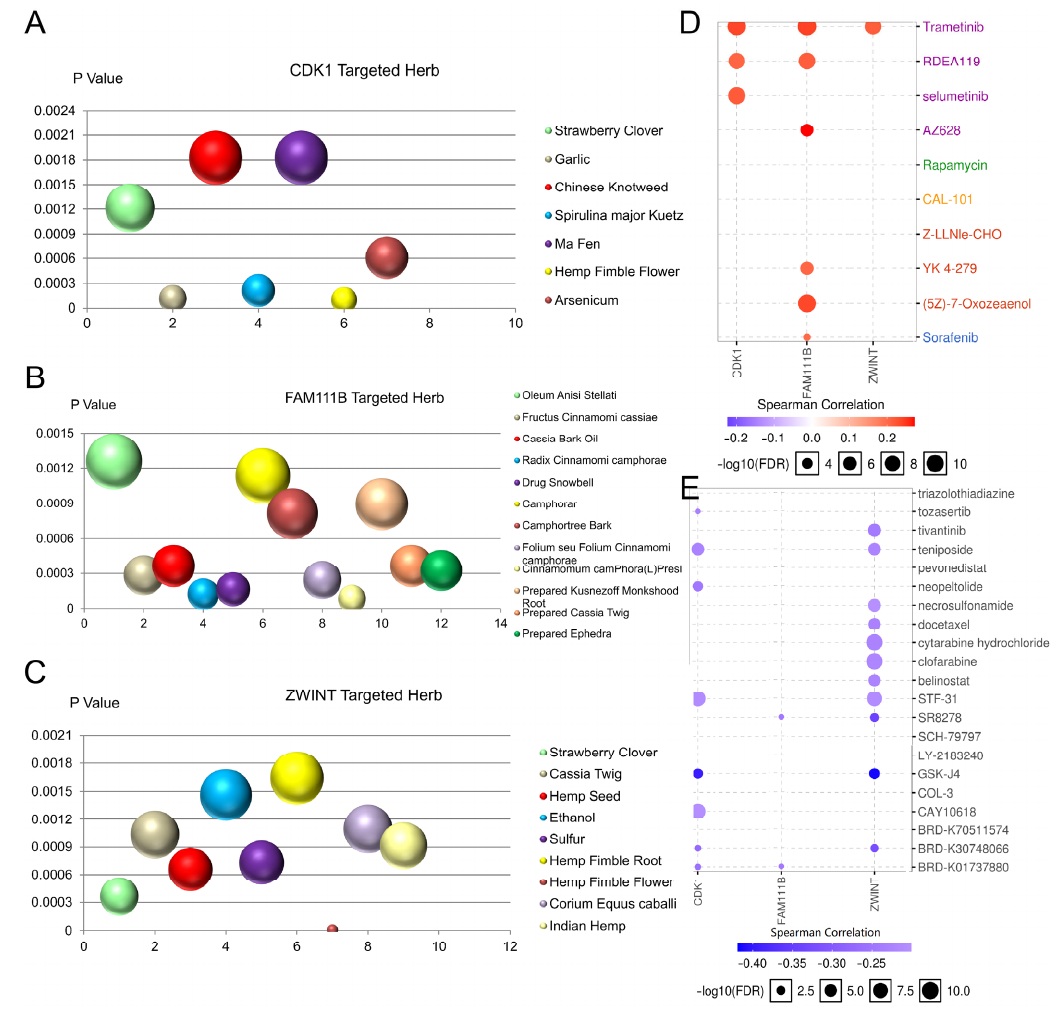
Figure 5. Targeted herbs and drug sensitivity analysis of CDK1, FAM111B and ZWINT. ( A – C ) Herbs targeting ( A ) CDK1, ( B ) FAM111B and ( C ) ZWINT. ( D , E ) Analysis of the correlation between CDK1, FAM111B, ZWINT and drug sensitivity based on ( D ) CTRP database and ( E ) GDSC database.